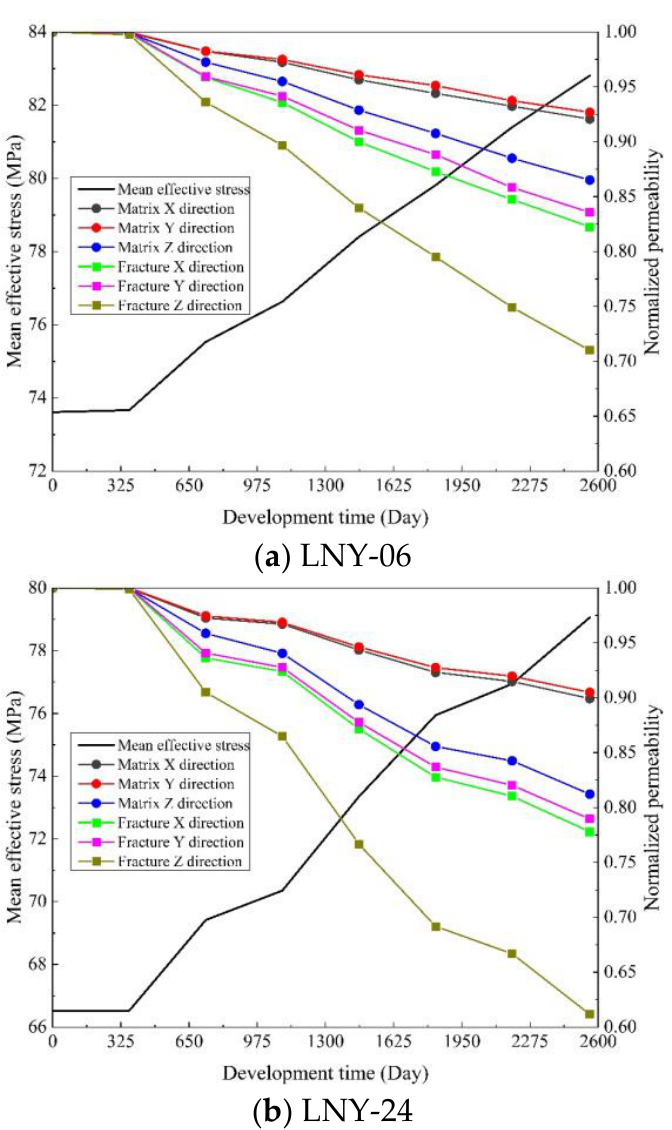
Figure 16. Normalized permeability and mean effective stress around the well.